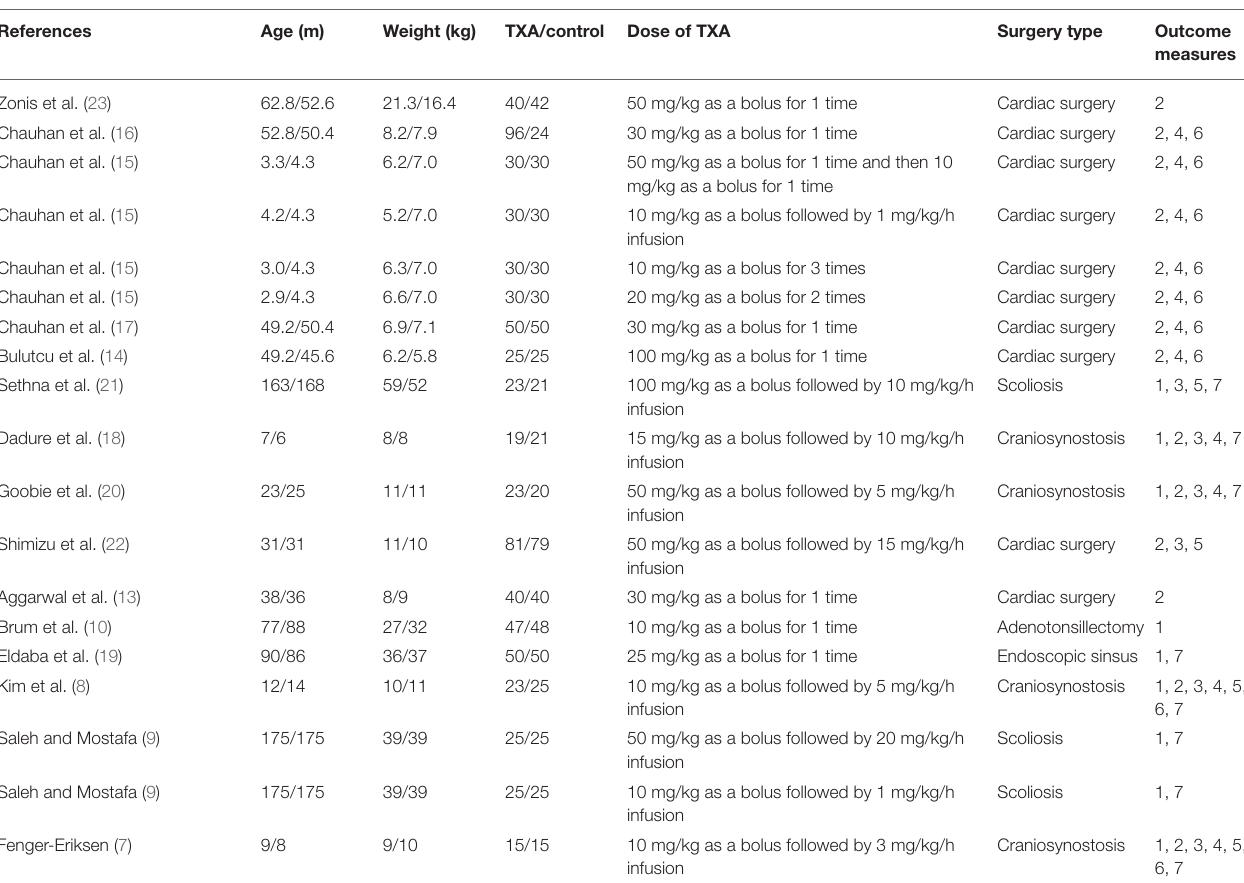
TABLE 1 | Characteristics of included studies.